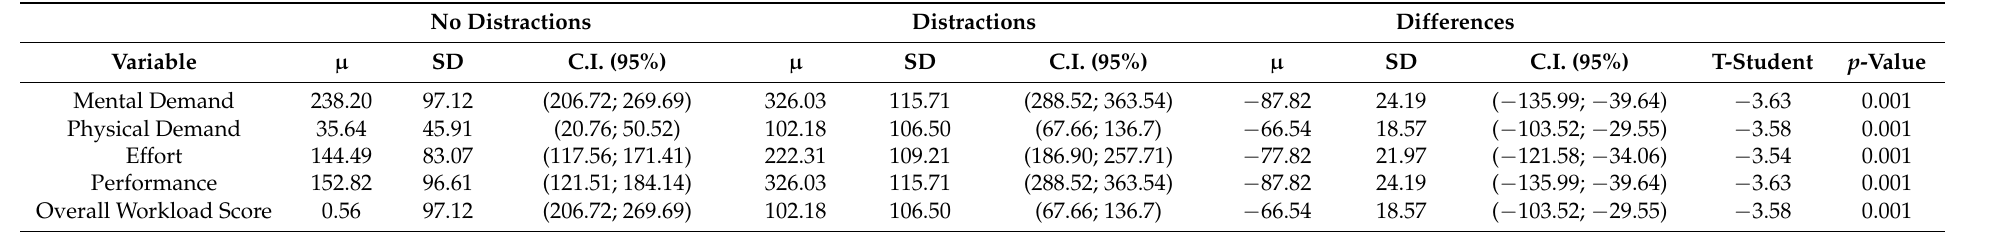
Table 5. Comparison of the results of NASA-TLX dimensions during the two drives. No Distractions